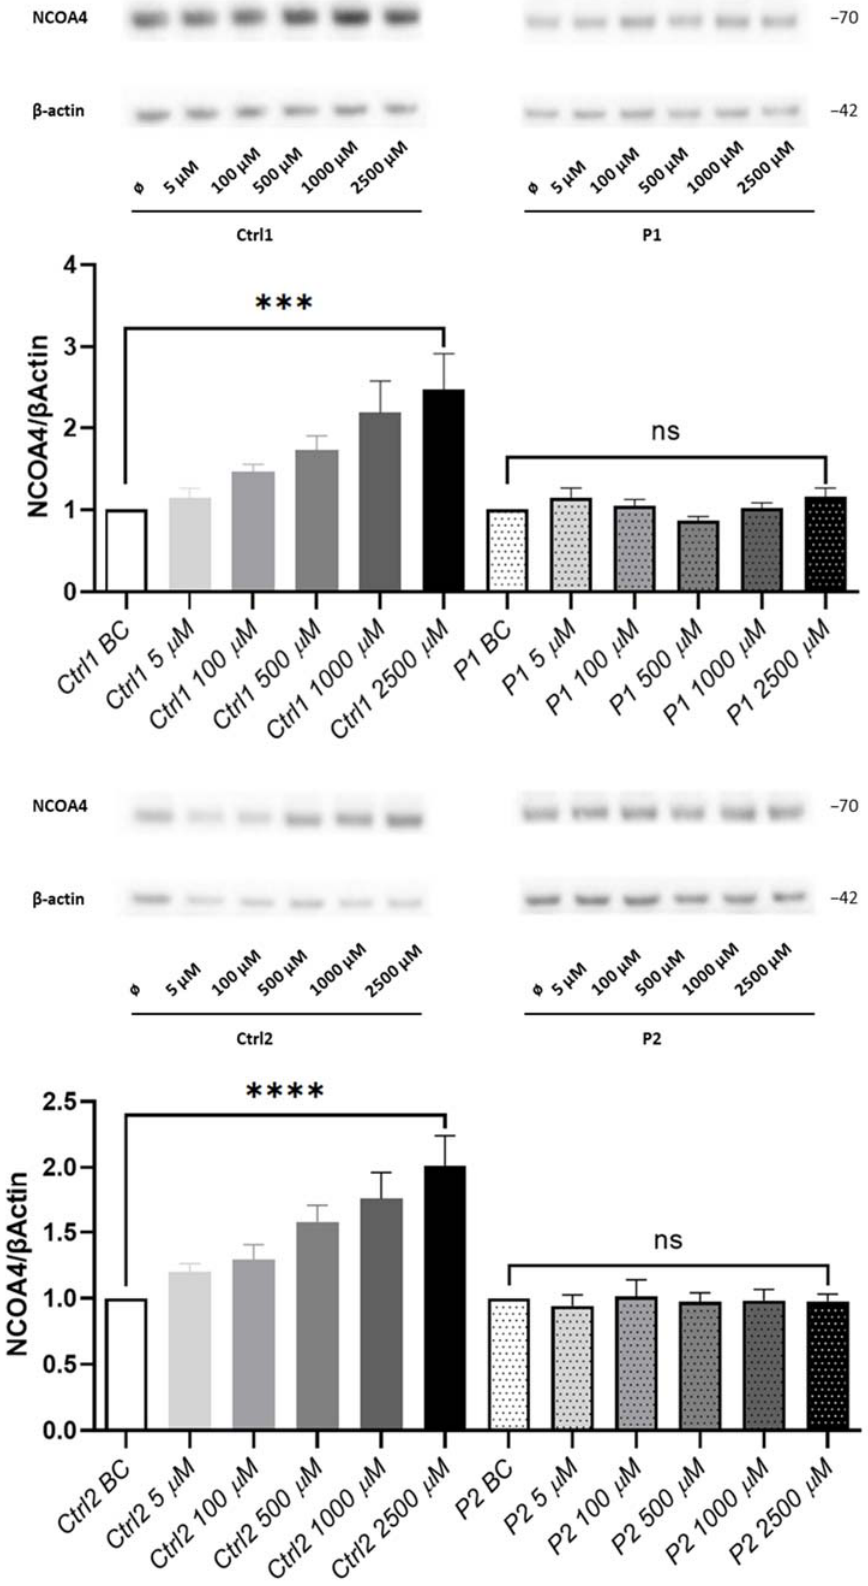
Figure 5. Loss of WDR45 is linked to disrupted iron recycling via ferritinophagy. Western blot analysis of total protein extract from fibroblasts from: WDR45 mutation carriers (P1 and P2) and two healthy controls (Ctrl1 and Ctrl2) with antibody against NCOA4 and β -actin (loading control)